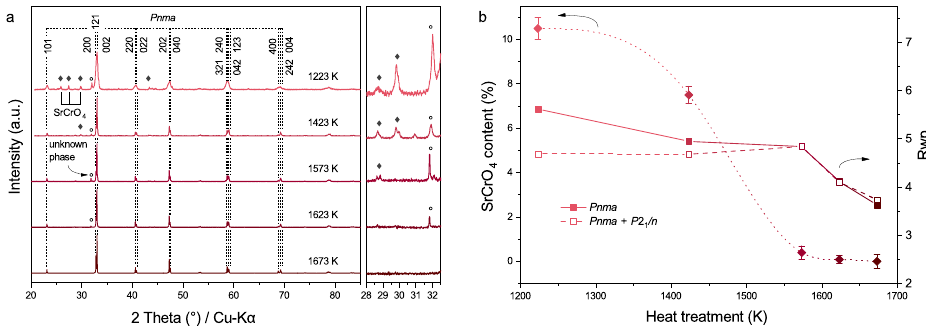
Figure 3. ( a ) Room-temperature XRD patterns of Pr 0.5 Sr 0.5 (Cr,Mn,Fe,Co,Ni)O 3– δ powders treated at temperatures in the range of 1223K to 1673K followed by natural cooling. The cooling rates are shown in Figure A2. Reflections of the main phase were indexed according to the Rietveld refinement using PrCrO 3 ( Pnma , ICSD 251098) as the starting structure. The diamond symbols denote Bragg positions of SrCrO 4 ( P 2 1 / n , ICSD 40922). ( b ) The influence of heating temperatures on the SrCrO 4 content and the corresponding Rwp factors obtained by Rietveld refinements.